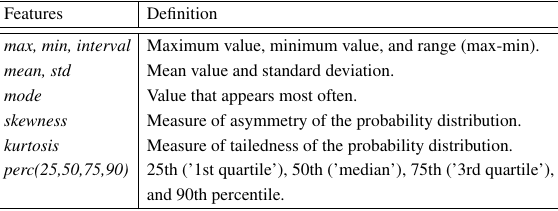
Table 2. Object-based statistical MS features.